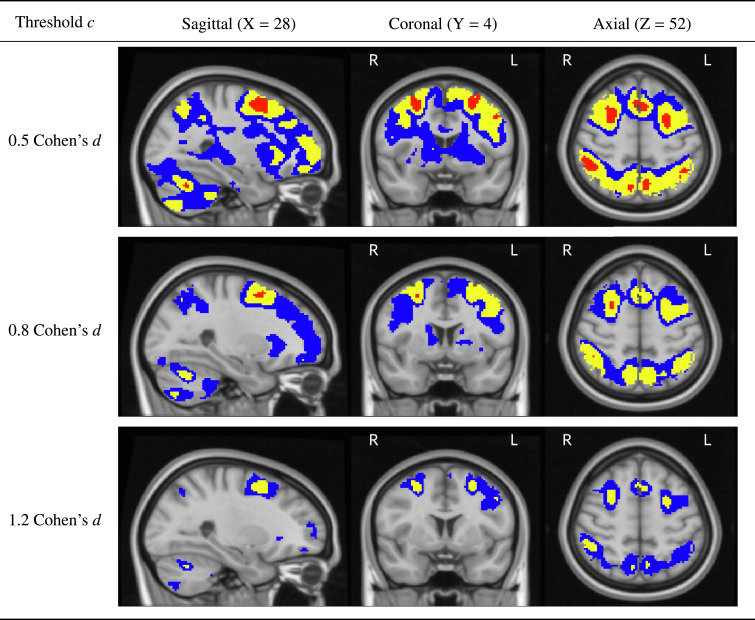
S.1:Slices views of the Cohen’s d Confidence Sets obtained from applying Algorithm 1 to the HCP working memory task data, using three Cohen’s d effect size thresholds, c=0.5,0.8 and 1.2. Comparing with Fig. 12 and Fig. D.2, the CSs presented here are slightly more conservative than the corresponding CSs obtained with Algorithms 2 and 3 (in the sense that the red upper CSs here are smaller, and blue lower CSs are larger). This is consistent with the simulation results obtained in Sections 4.1 and 4.2, where the empirical coverage for Algorithm 1 was consistently larger than the other two methods.